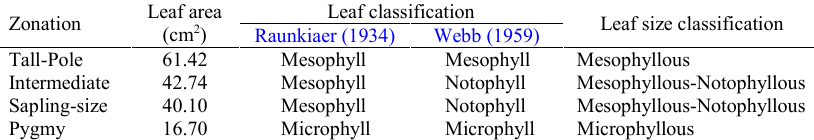
Vegetation Zones Fig. 6: Variation in leaf macronutrients Fig. 6: Variation in leaf macronutrients Table 4: Leaf size classification of the vegetation in Caimpugan PSF Table 4: Leaf size classification of the vegetation in Caimpugan